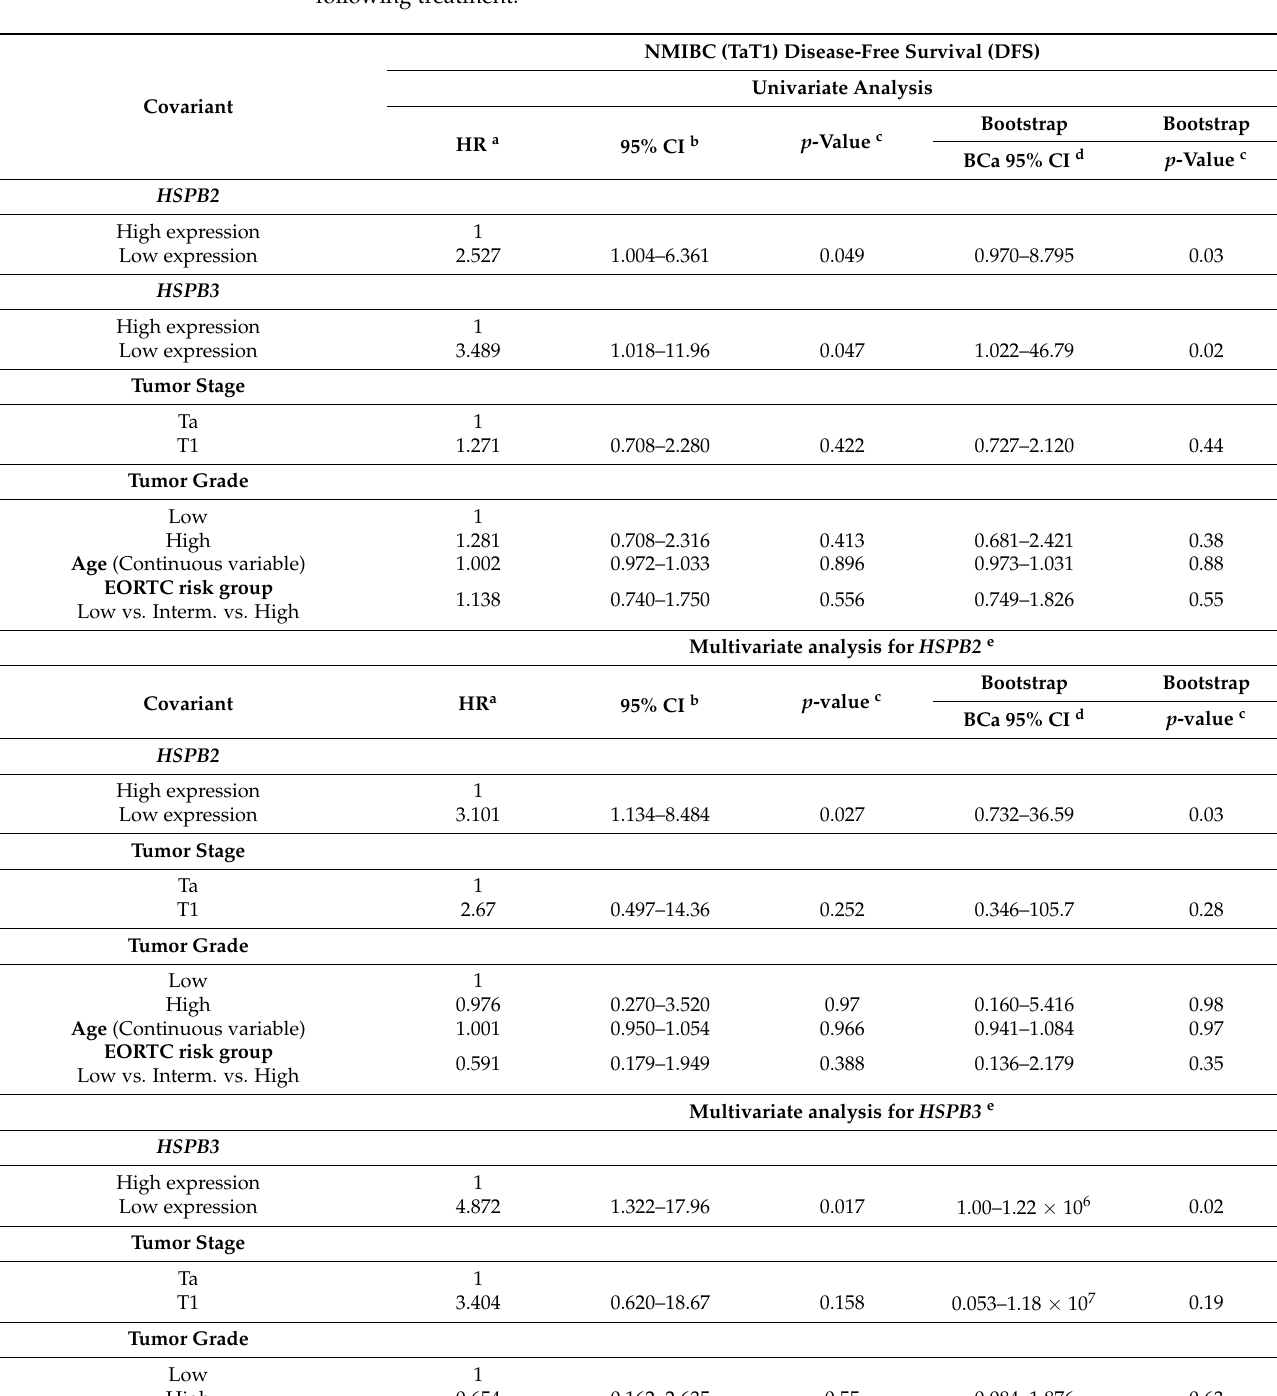
Table 2. Cox regression analysis for the prediction of NMIBC (TaT1) patients’ risk for relapse (DFS) following